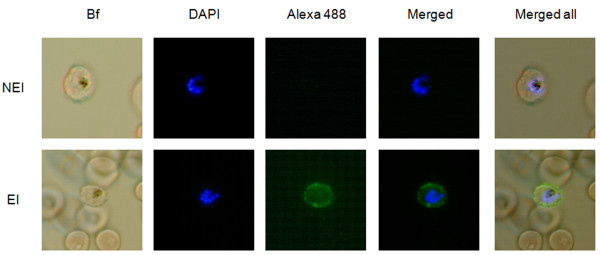
Evaluation of human serological response against RBC infected by RP8 P. falciparum strain by liquid indirect immunofluorescence assay (L-IFA). Representative IgG response against iRBC from a non-exposed individual (NEI, upper row) and a briefly exposed individual (BEI, lower row) to malaria, are shown. Specific antibody response to surface proteins from live iRBC was revealed with alexa 488 goat anti-human IgG antibodies (green). P. falciparum DNA was stained with DAPI (blue), and merged images with bright field (BF) are shown (Magnification × 100).